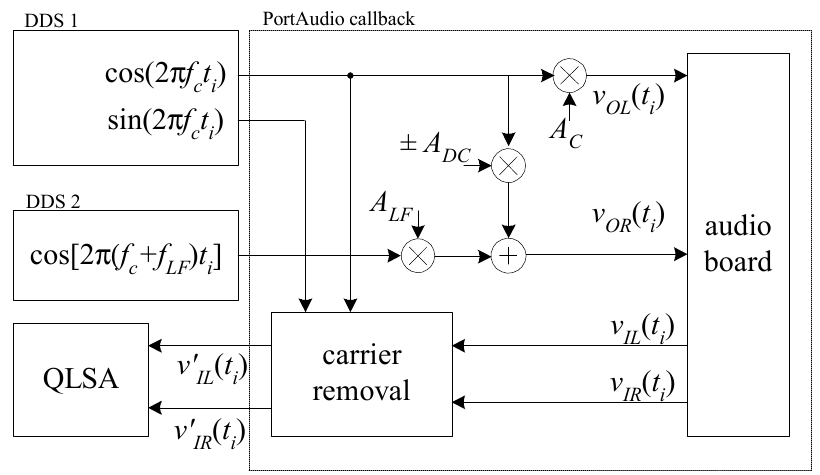
Figure 3. Simplified diagram illustrating the interaction among the different software routines for signal generation, acquisition, and elaboration.